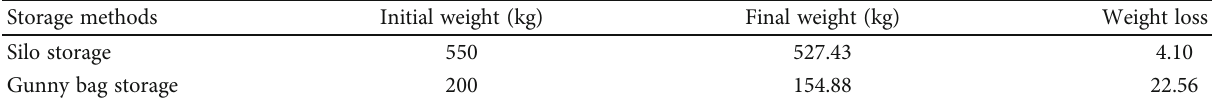
Table 5: Physiological loss in weight of grains.